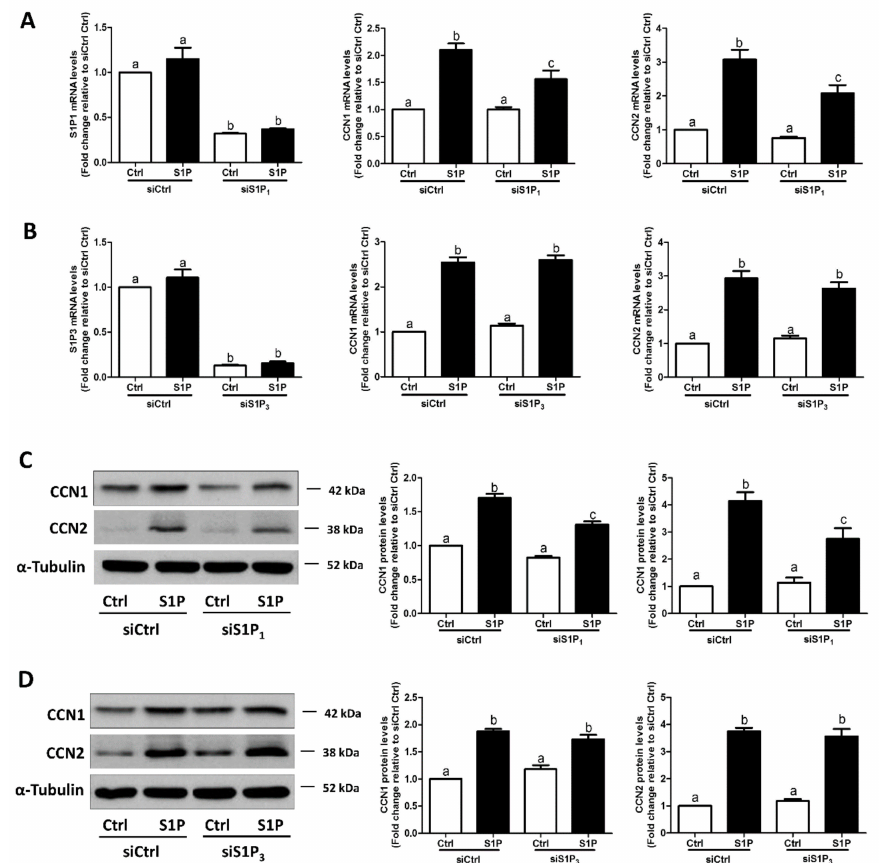
Figure 4. S1P 1 mediates the S1P-induced upregulation of CCN1 and CCN2 expression in SVOG cells. ( A ) SVOG cells were transfected with 75 nM control siRNA (siCtrl) or 75 nM S1P 1 siRNA (siS1P 1 ) for 48 h, followed by treatment with a vehicle control or 0.3 µ M S1P for 1 h. The mRNA levels of S1P 1 , CCN1, and CCN2 were examined using RT-qPCR. ( B ) SVOG cells were transfected with 75 nM siCtrl or 75 nM S1P 3 siRNA (siS1P 3 ) for 48 h, followed by treatment with a vehicle control or 0.3 µ M S1P for 1 h. The mRNA levels of S1P 3 , CCN1, and CCN2 were examined using RT-qPCR. ( C ) SVOG cells were transfected with 75 nM siCtrl or 75 nM siS1P 1 for 48 h, followed by treatment with a vehicle control or 0.3 µ M S1P for 2 h. The protein levels of CCN1 and CCN2 were examined using western blot analysis. ( D ) SVOG cells were transfected with 75 nM siCtrl or 75 nM siS1P 3 for 48 h, followed by treatment with a vehicle control or 0.3 µ M S1P for 2 h. The protein levels of CCN1 and CCN2 were examined using western blot analysis. The results are presented as the mean ± SEM of at least three independent experiments. If a pair of values is significantly di ff erent ( p < 0.05), the values have di ff erent subscript letters (a vs. b or b vs. c) assigned to